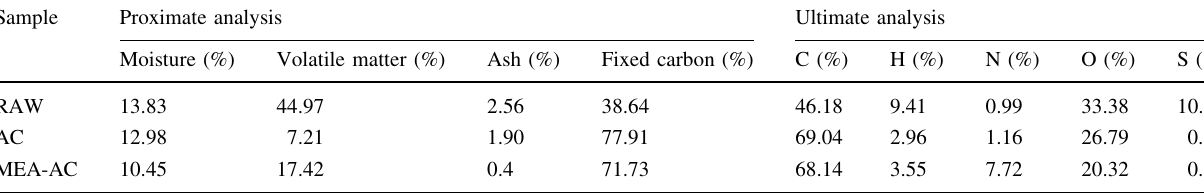
Table 7 Proximate and ultimate analysis of adsorbents (at optimum condition) Sample Proximate